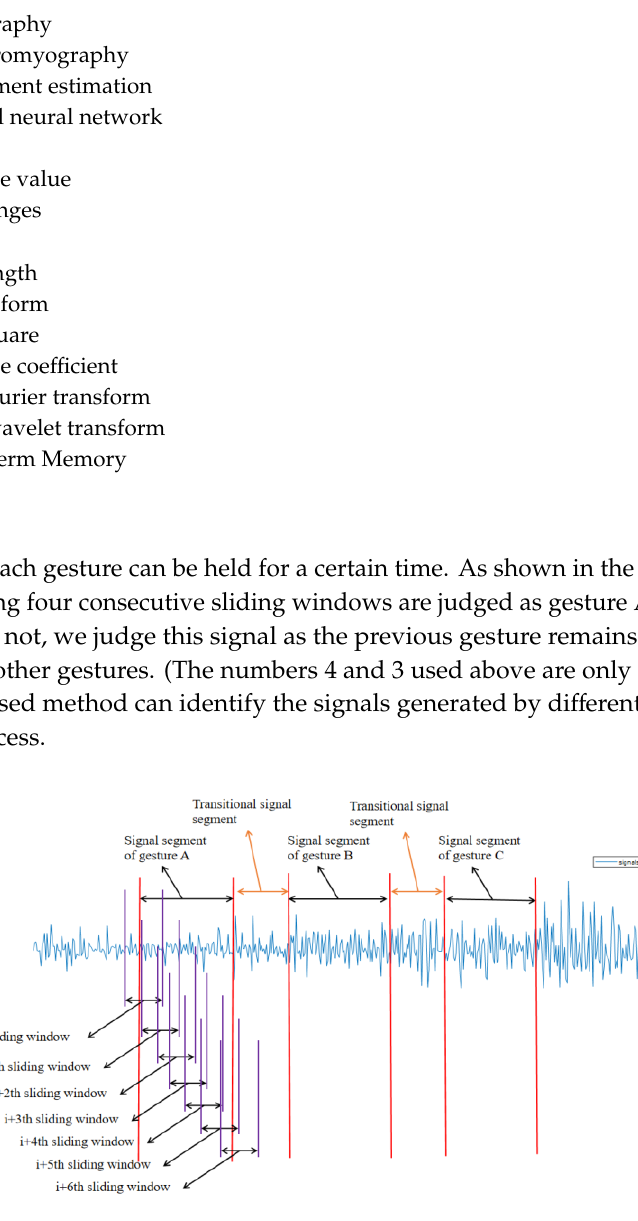
Figure A1. Schematic of continuous signal recognition.